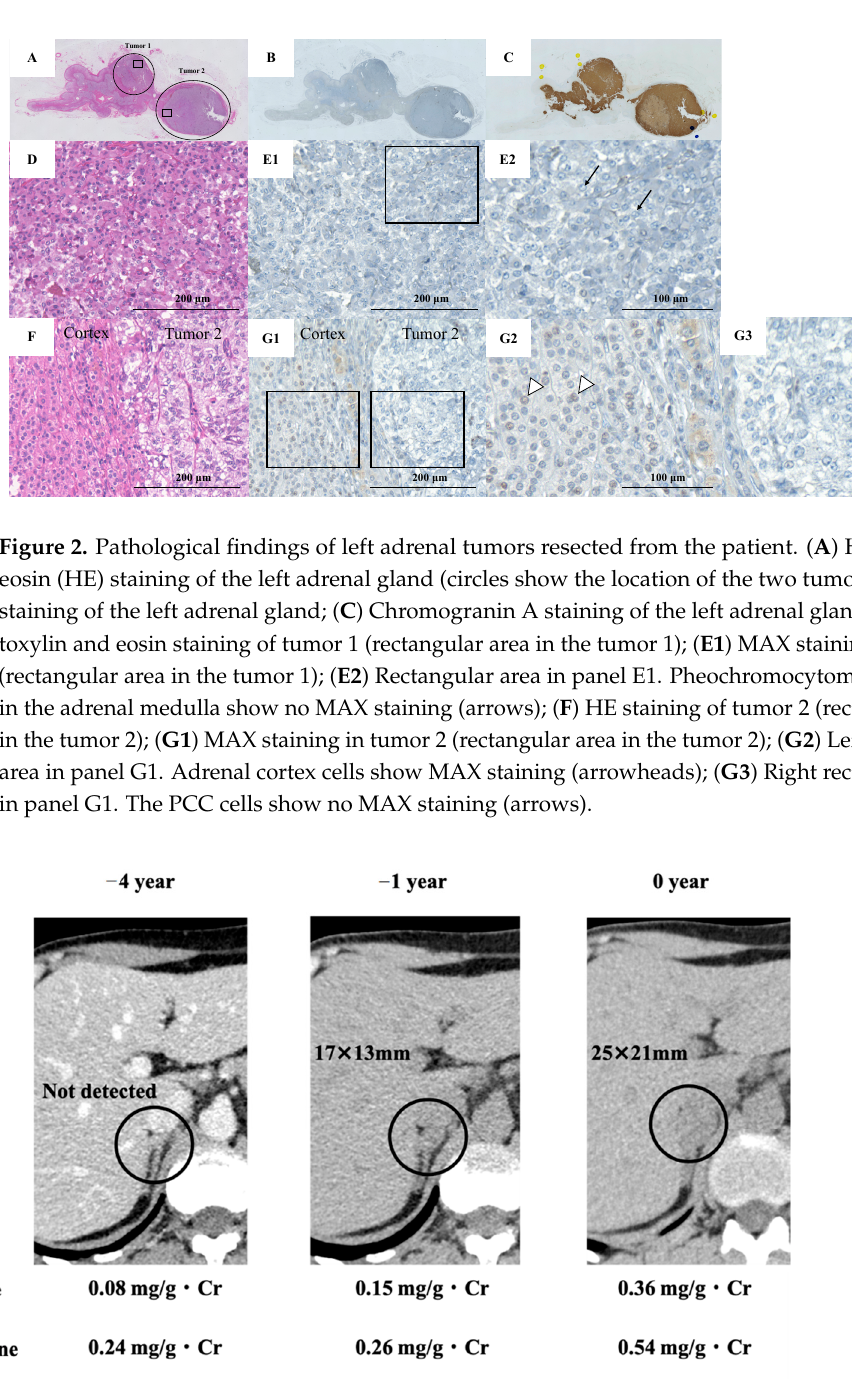
Figure 3. CT images of the right adrenal gland and changes in biochemical test results. Circles indi- cate right adrenal tumor. Urinary metanephrine and normetanephrine outputs increased with in- crease in the tumor size.